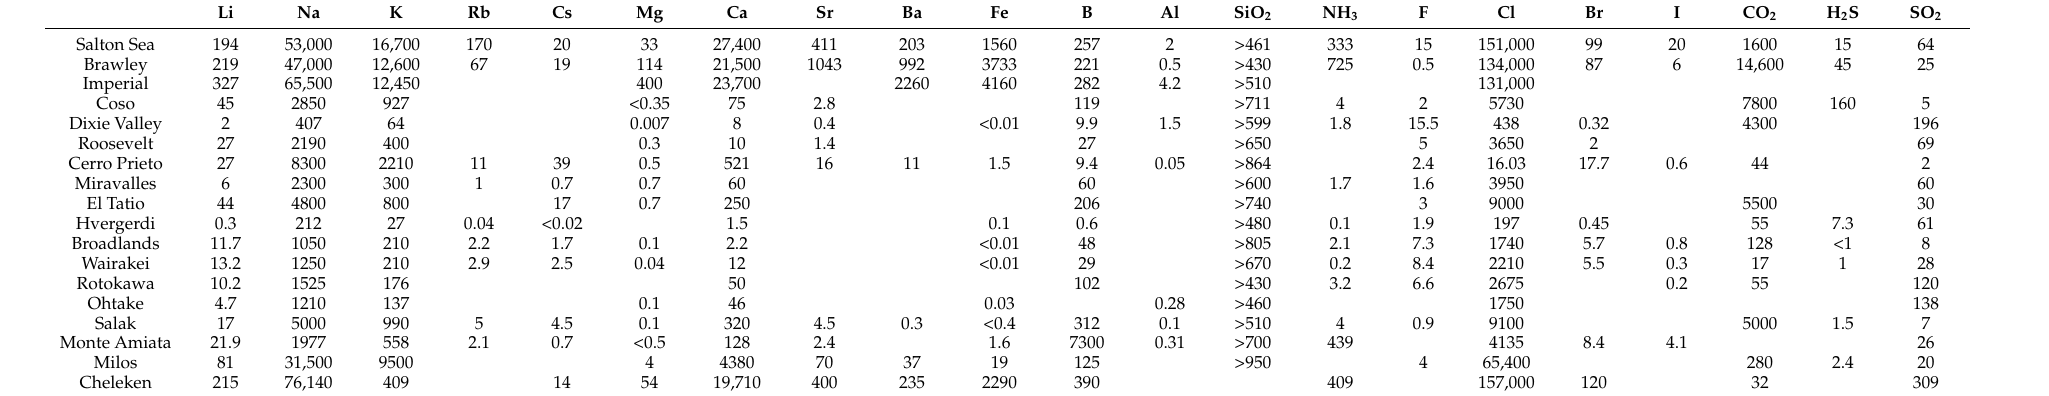
Table 12. Chemical composition of geothermal brines [272]. Values are reported in